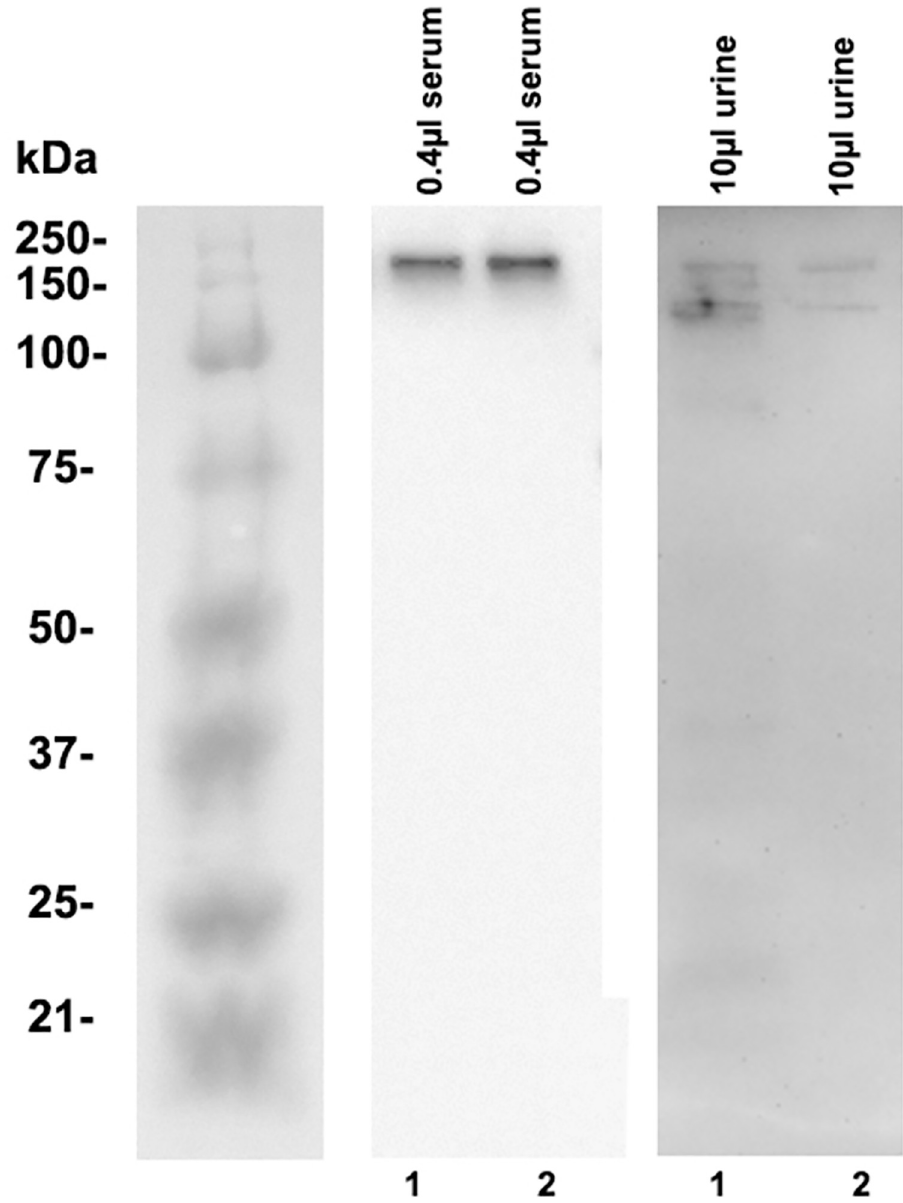
Fig 4. C3 serum und urine immunoblot using mAb 3F7E2. Ten μ l of human urine (patient#1 and #2) was loaded onto a 10% SDS-PAGE transferred to nitrocellulose and incubated with mAb 3F7E2 (right panel). 0.4 μ l of human serum (patient#1 and #2) was loaded onto a 10% SDS-PAGE transferred to nitrocellulose and incubated with mAb 3F7E2 (middle panel). Molecular weight marker is shown at the left panel. Shown is a representative experiment out of two. The entire 190 kDa C3 molecule was detected and exhibited some extent of degradation. C3a could not be delineated. with INF γ lead to an increase in C3 gene expression, indicating that C3 expression in glomeru- lar epithelial cells is regulated by INF γ [19]. In addition, increased local C3 synthesis has been described in human diseases, such as postischemic acute renal failure and immune-mediated nephritis [2, 22].